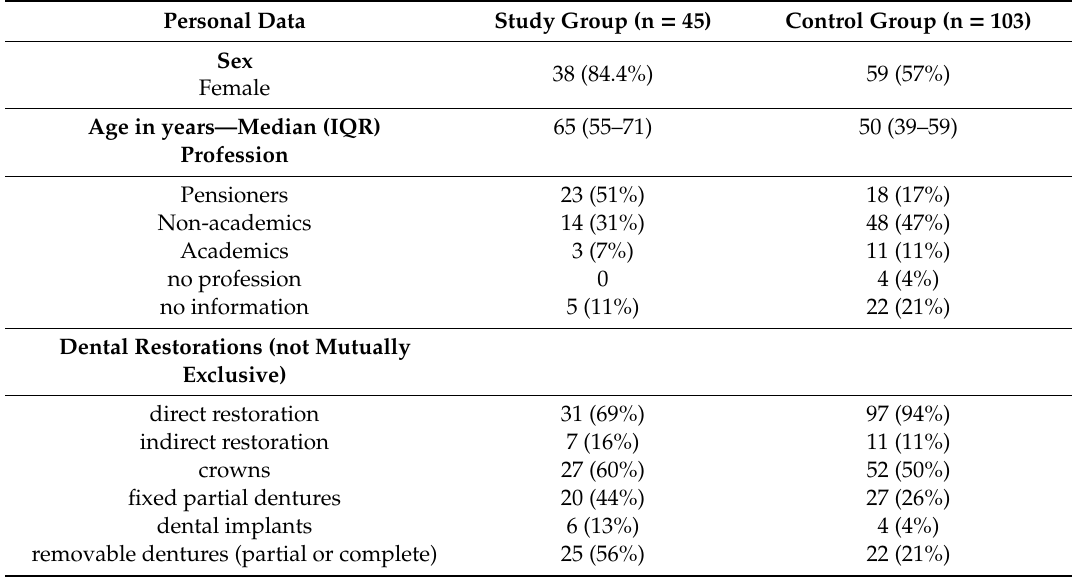
Table 1. Sociodemographic and dental restorations